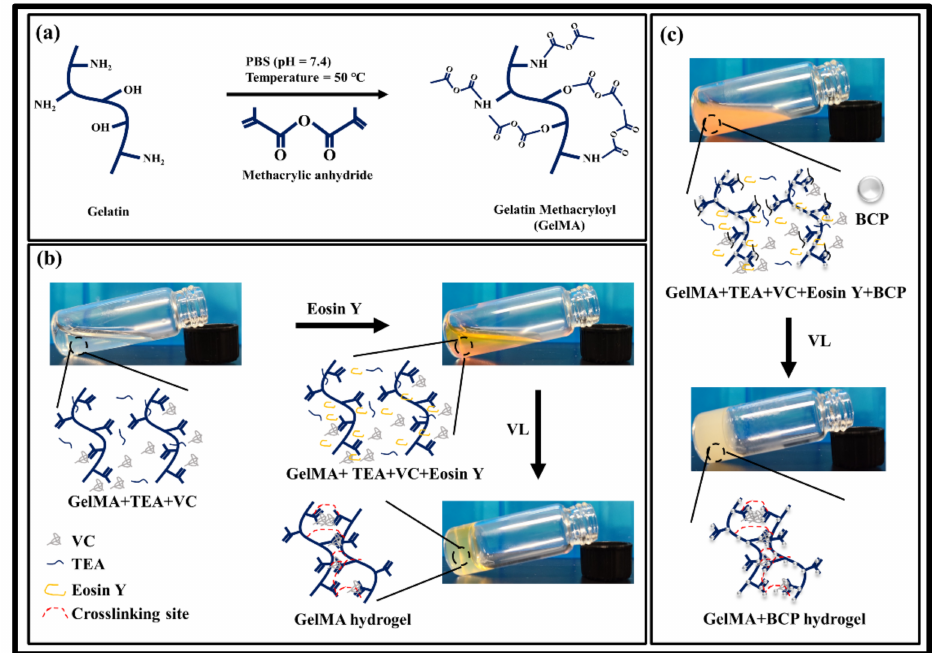
Figure 1. Schematic diagram of network structure formation on ( a ) gelatin methacryloyl, ( b ) gelatin methacryloyl hydrogel, and ( c ) biphasic calcium phosphate nanoparticles (BCP-NPs)-bonded gelatin methacryloyl